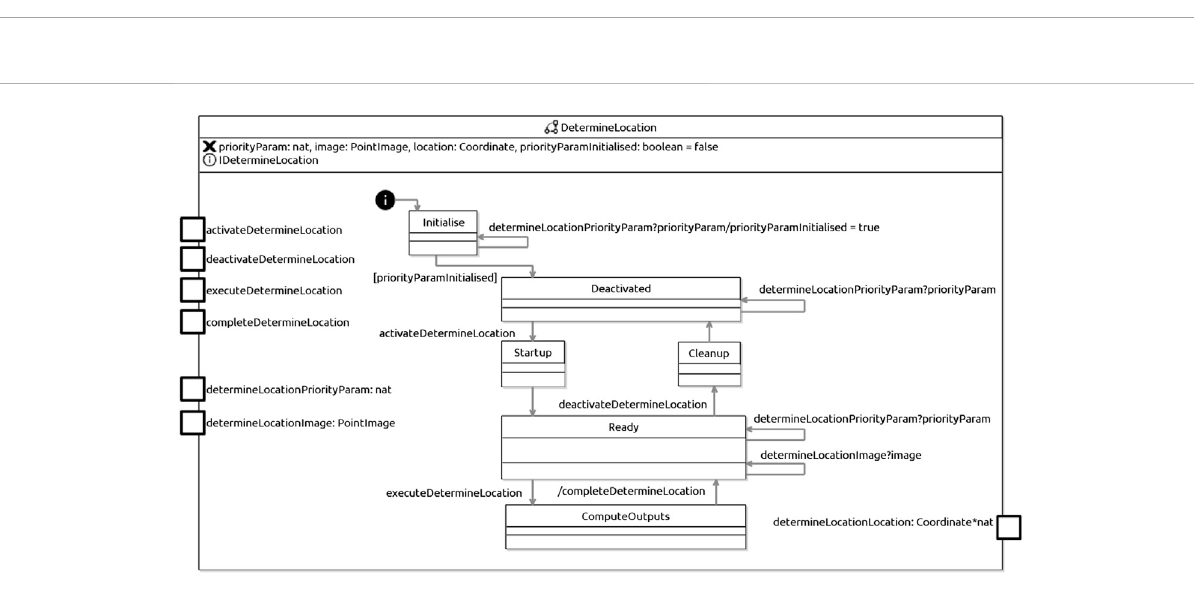
FIGURE 8 RoboChart state machine for DetermineLocation